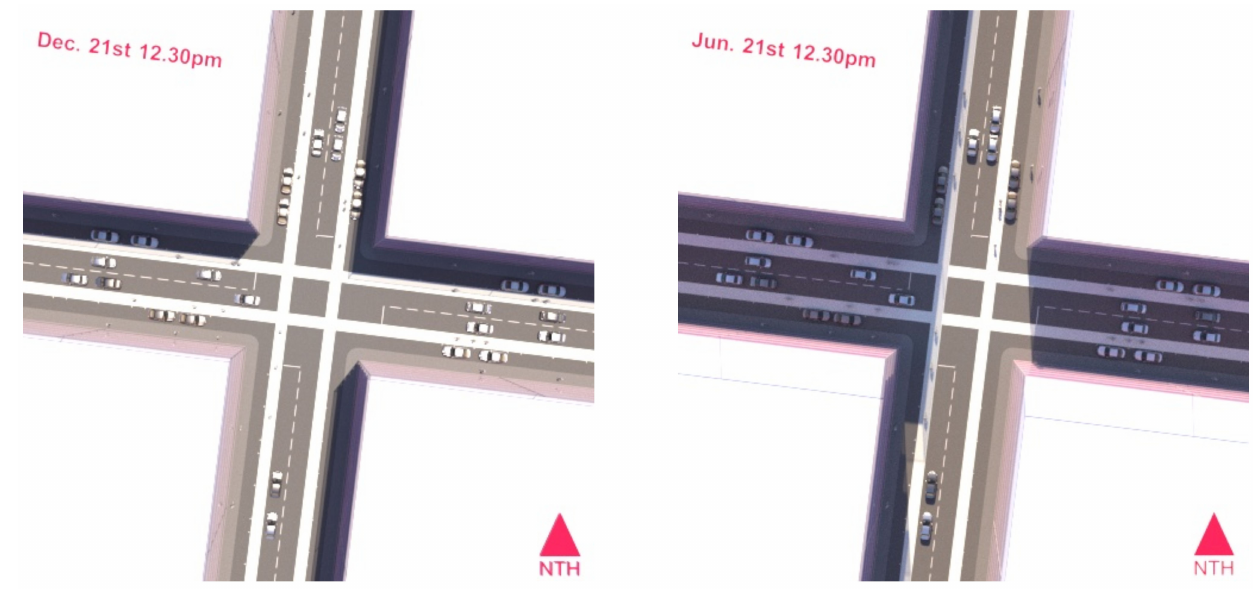
Figure 1. An intersection of a street with equal building height to street width ratio. LEFT 12:30 in summer; RIGHT 12:30 in winter. Higher density can still leave pedestrians exposed in summer; on this orientation, winter solar access could be preserved on the western side of north–south oriented streets. Image by authors using Autodesk™ 3ds